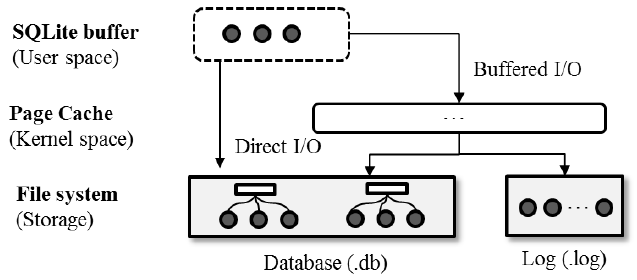
Figure 2. Overall architecture of